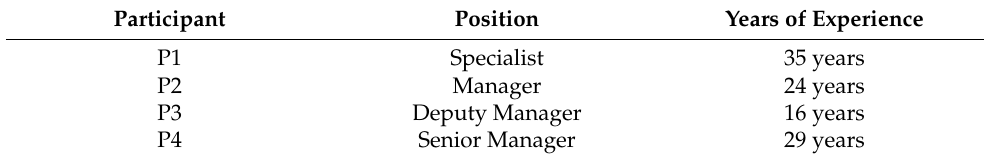
Table 4. Profile of Focus Group Participants.